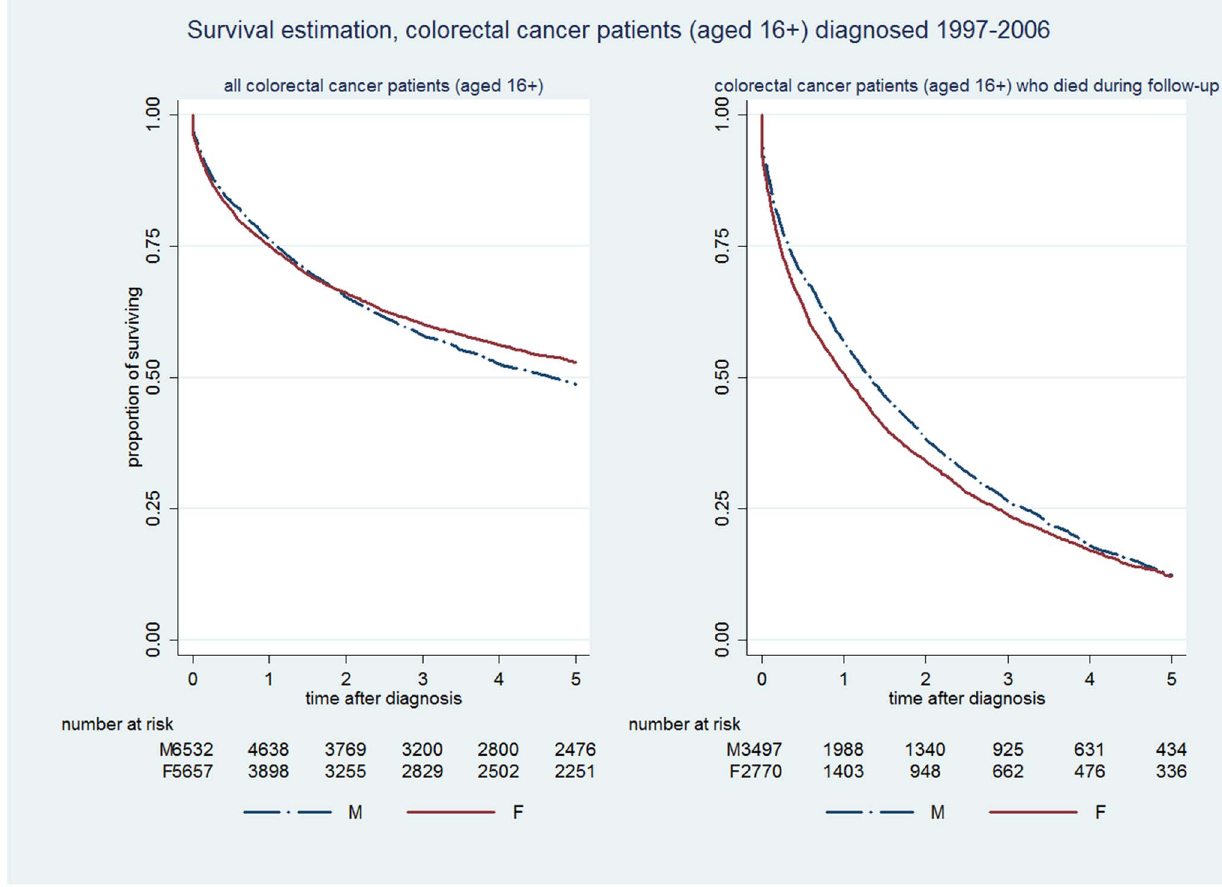
Figure 1.Kaplan-Meier survival curves for colorectal cancer patients (diagnosed between 1997–2006).